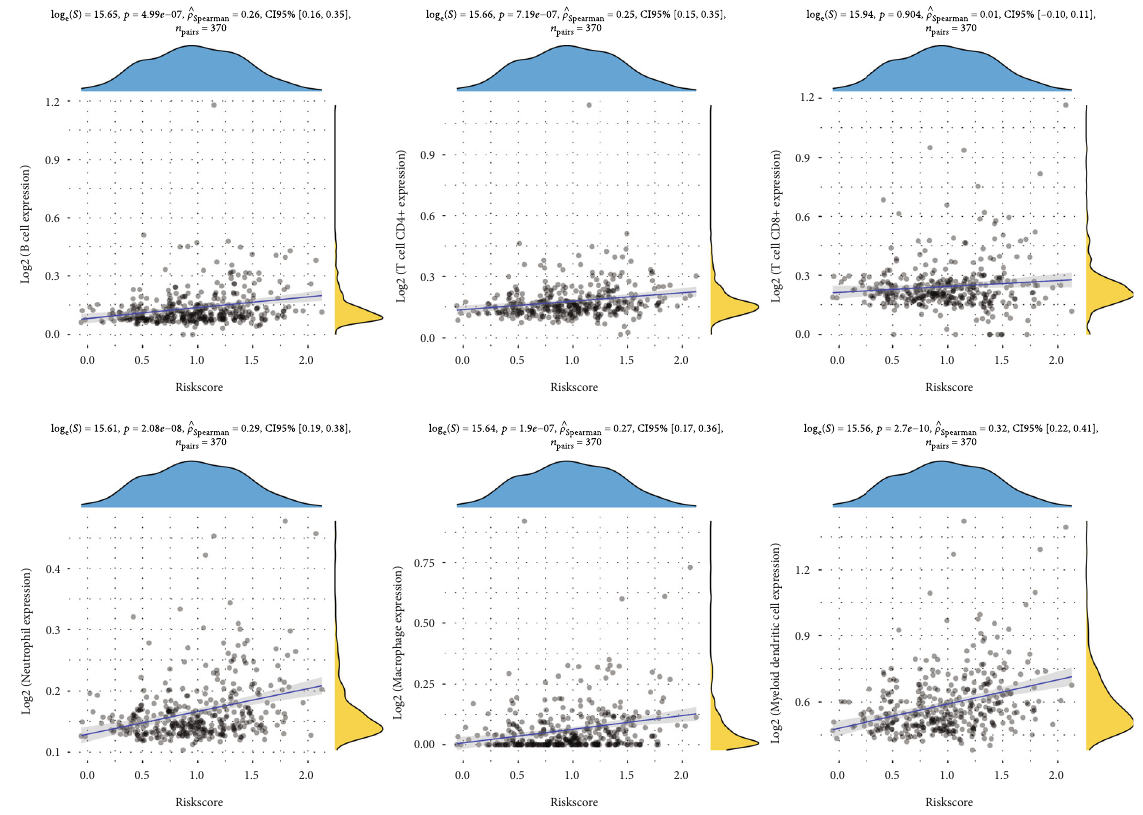
Figure 11: Relationship of risk score to immune in fi ltration level in HCC. Risk score has a distinct positive association to in fi ltrating levels of B cells, T cell CD4+ cells, neutrophil, macrophage, and myeloid dendritic cells in